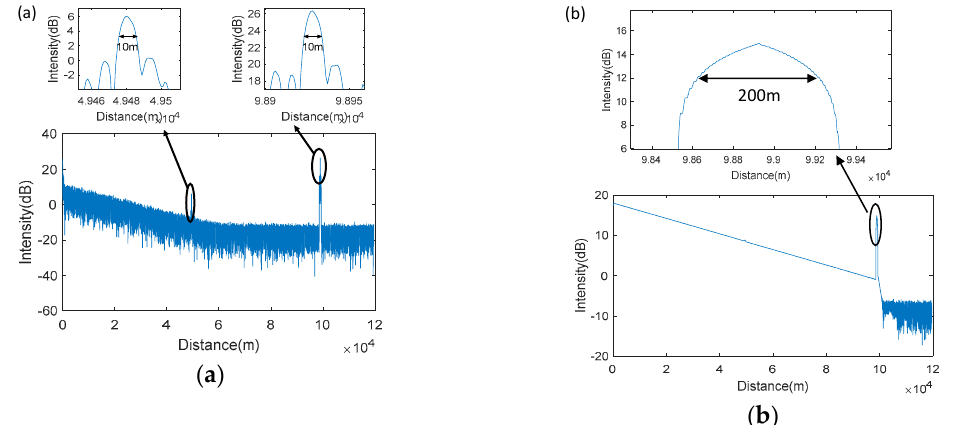
Figure 8. Measurement results of the Hamming short-time fractional Fourier transform window. ( a ) Considering only the primary linear frequency modulation signal in the backscattered signal and ( b ) adding the direct current component.